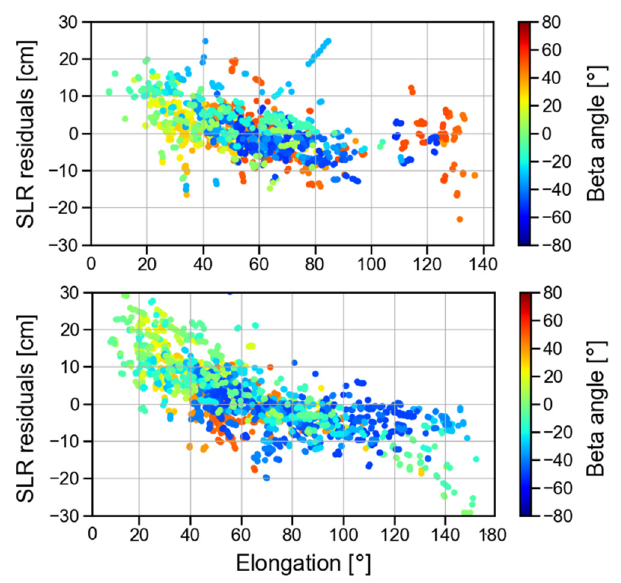
Figure 3. Distribution of the SLR residual with respect to the Sun elongation angle ( ϵ ) for C08 ( top ) and C13 ( bottom ) determined with the ABW model.